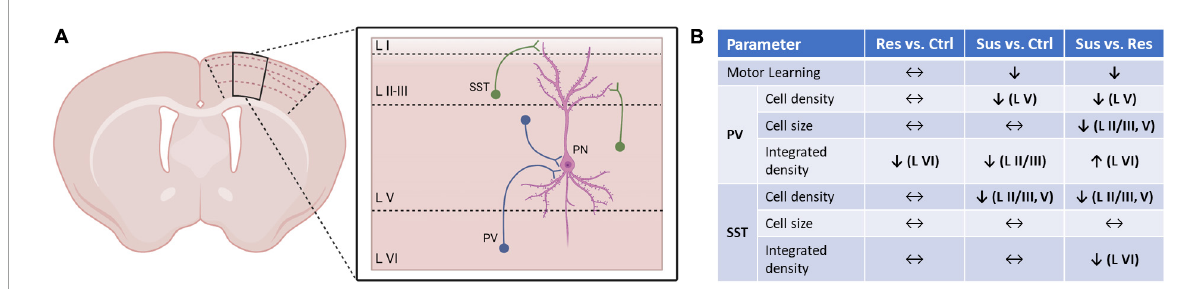
FIGURE4 Summary of the quantitative and qualitative changes in interneuronal networks of M1 and its layers dependent on individual stress vulnerability. (A) Schematic network of parvalbumin positive (PV+) and somatostatin positive (SST+) interneuron populations investigated in this study and the principal neurons (PN) of layer V of the primary motor cortex (black outline on coronal section) previously found to be affected by CSDS (6). (B) Comparisons between the stress phenotypes (Res, Sus) and controls (Ctrl), and between the stress phenotypes to dissect the implication of stress vulnerability for motor cortical interneurons also in relation to motor learning abilities on the